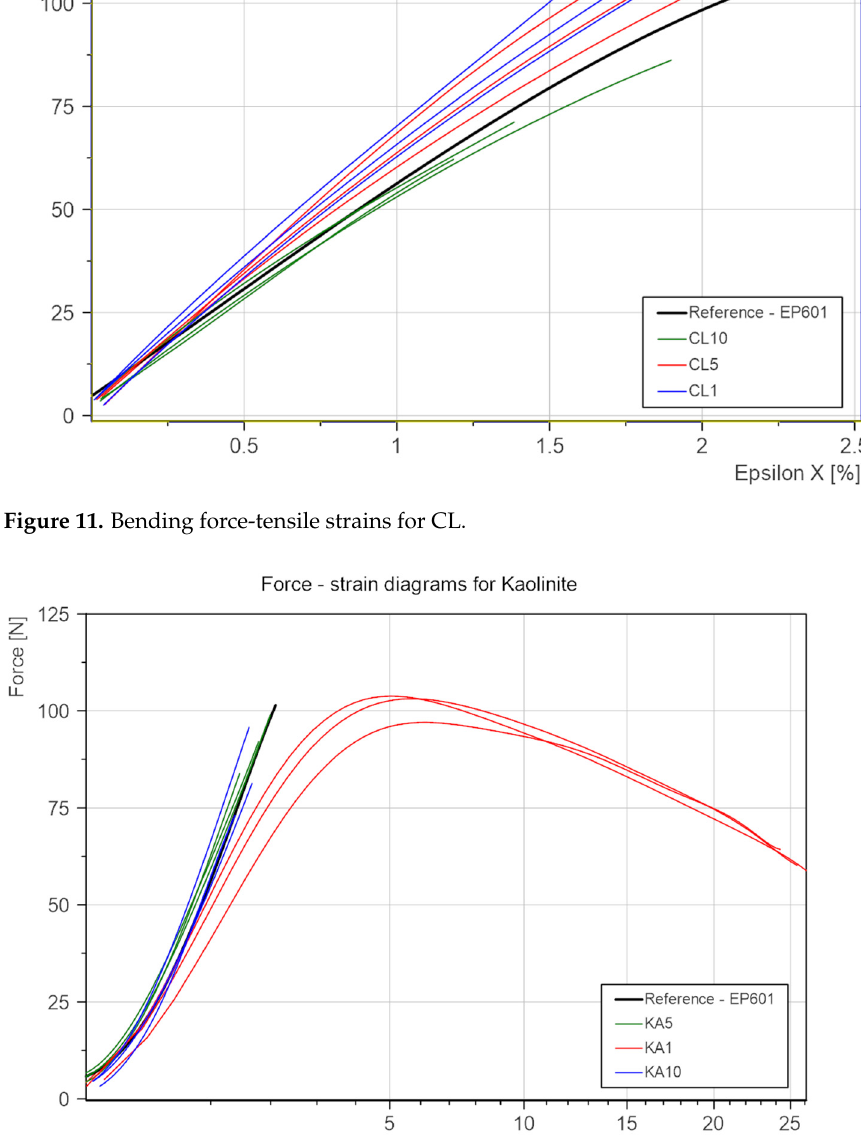
371 Figure 13. Percentage influence on improvement/deterioration of strength properties.